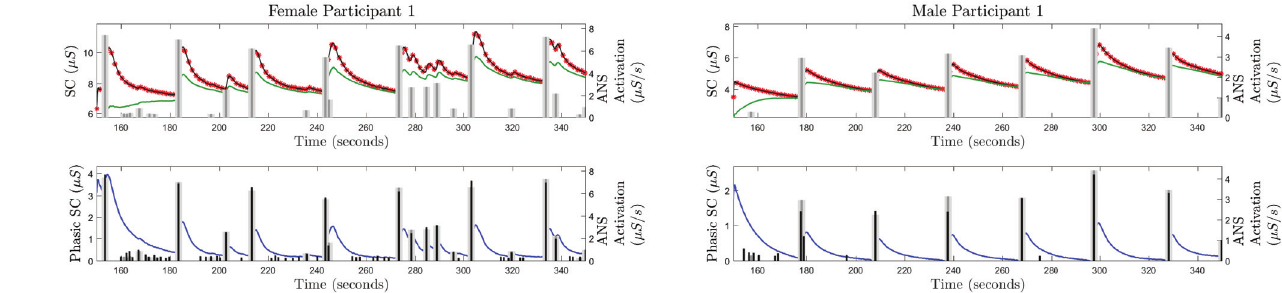
Fig 6. Deconvolution results from the simulated SC signals with 35 dB SNR for one female participant and one male participant. In each of the panels, i) the top sub-panel shows the ground truth for SC signal (red stars), the reconstructed SC signal (black solid curve), the estimated tonic component (green solid curve), and ground truth for the ANS activation (gray vertical lines); ii) the bottom sub-panel shows the estimated phasic component (blue solid curve), estimated ANS activation timings and amplitudes (black vertical lines) and the ground truth ANS activation (gray vertical lines).